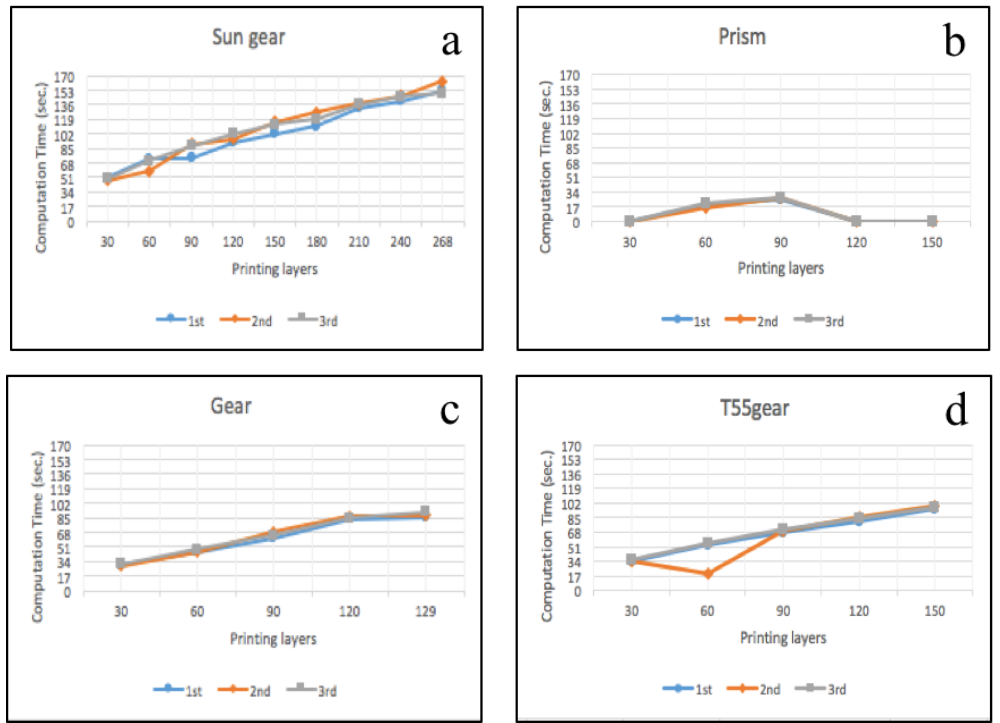
Figure 11. Image pre-processing—SIFT and RANSAC rescale and rectification: the computational time of normal printing state for ( a ) sun gear; ( b ) Prism; ( c ) gear; and ( d ) t55gear. Failure Printing State